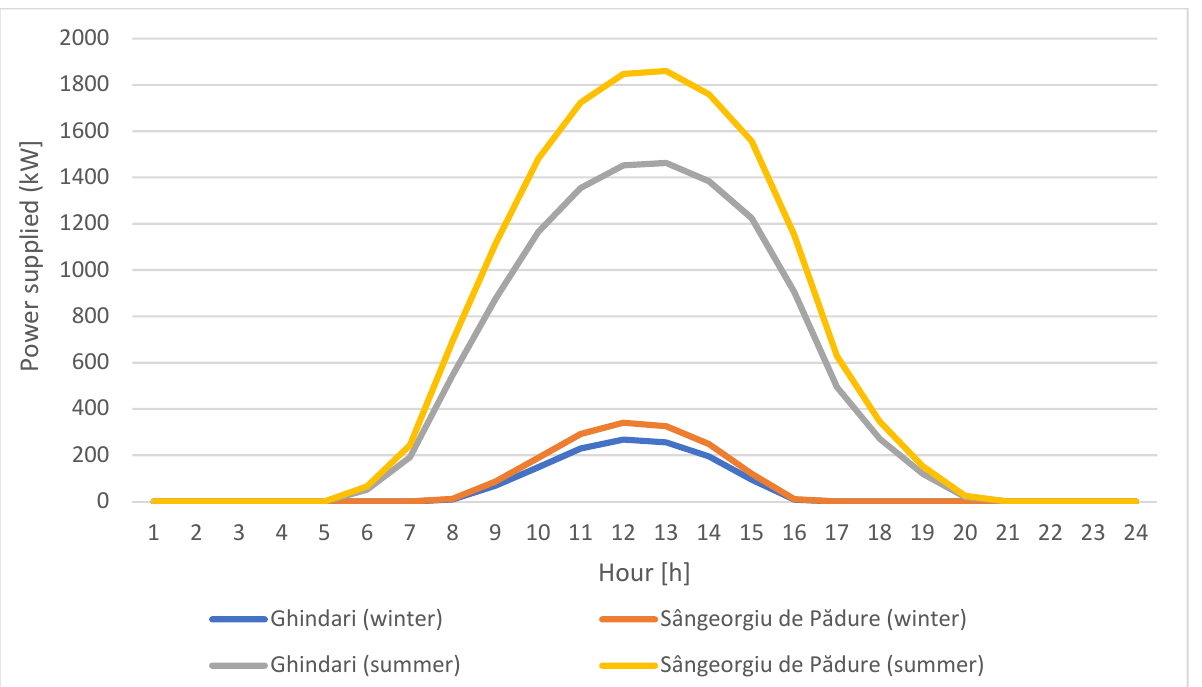
Table 2. Load data.